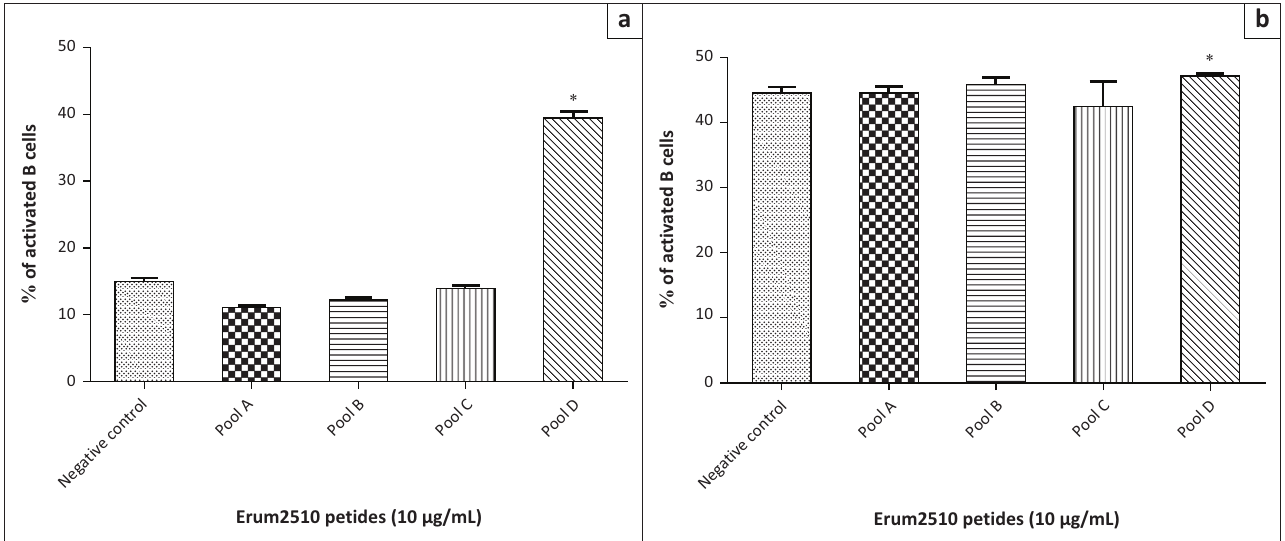
FIGURE 6: Average percentage of peripheral blood mononuclear cells (PBMCs) from s6823 (a) and sM2 (b) that stained positive for B cell expression markers after stimulation with Erum2510 peptide pools. Peripheral blood mononuclear cells were stimulated with 10 µg/mL protein and incubated for 72 h, after which the percentage of cells was determined by flow cytometry. Unstimulated PBMCs were included as negative